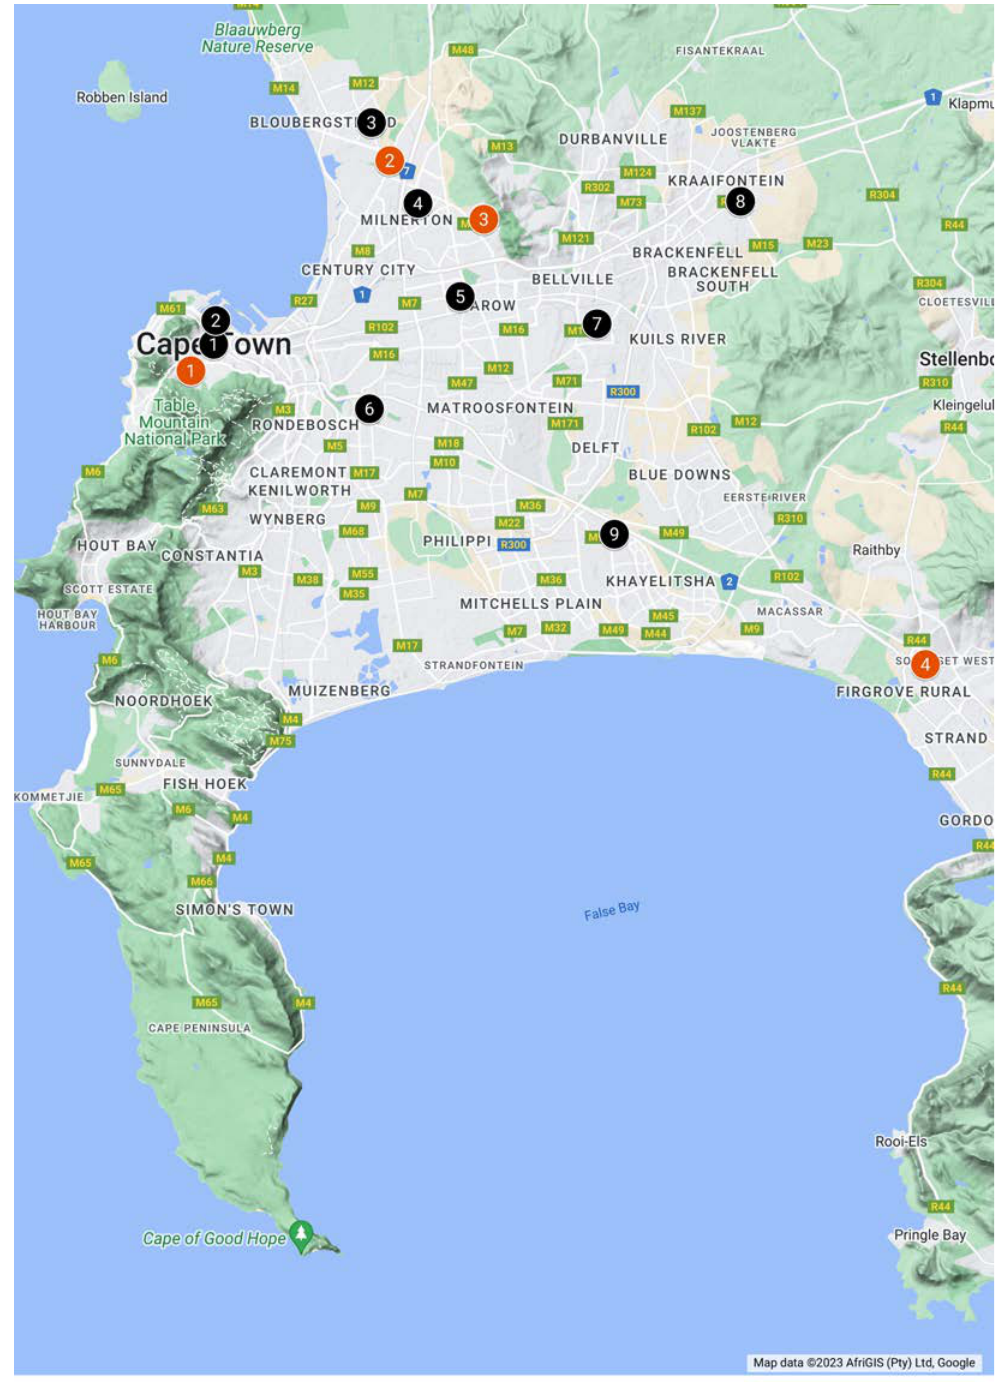
Figure 1. Ambient air quality monitoring stations in Cape Town, South Africa. City Hall (1), Fore- shore (2), Tableview (3), Bothasig (4), Goodwood (5), Athlone (6), Bellville South (7), Wallacedene (8) and Khayelitsha (9). Excluded stations in red: Molteno (1), Potsdam (2), Plattekloof (3) and Someset West (4).